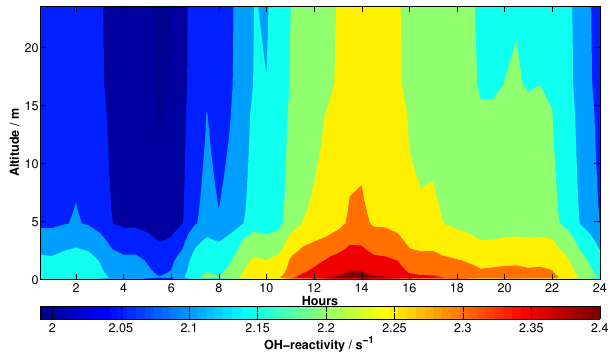
Fig. 9. Daily averaged modelled OH-reactivity as a function of alti- tude for January, February, March, November and December 2008.